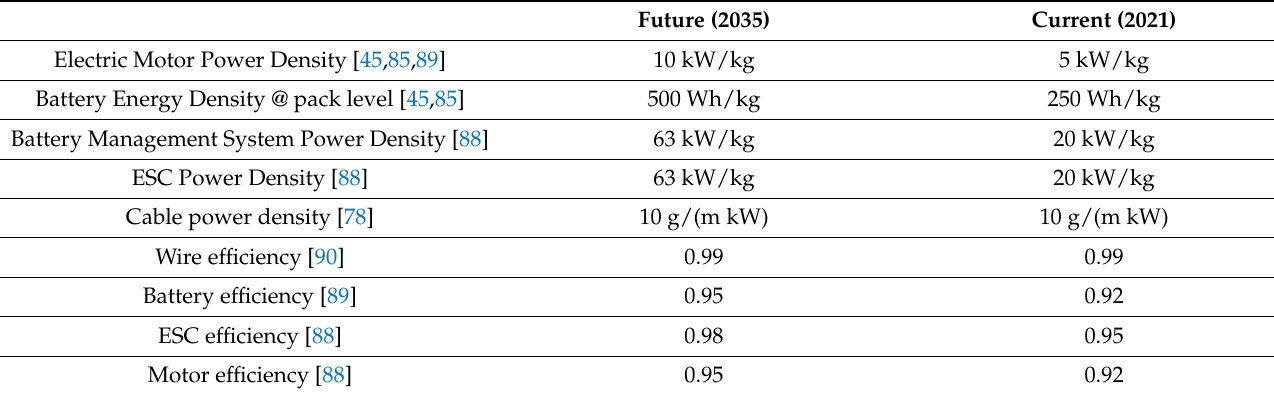
Table 12. Future (2035) and current technological parameters for powertrain components.